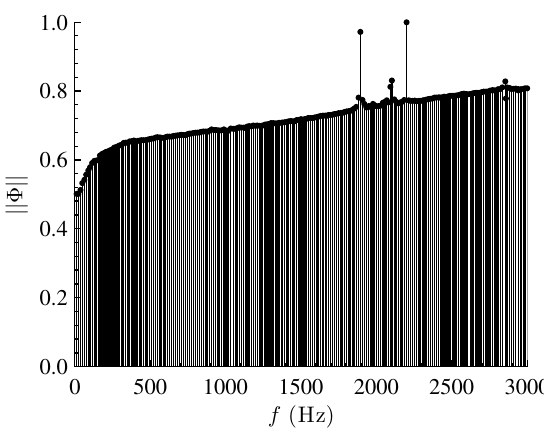
Figure 8. DMD energy spectrum of combined modes ( 2,1,0 ) and ( 1,2,0 ) .